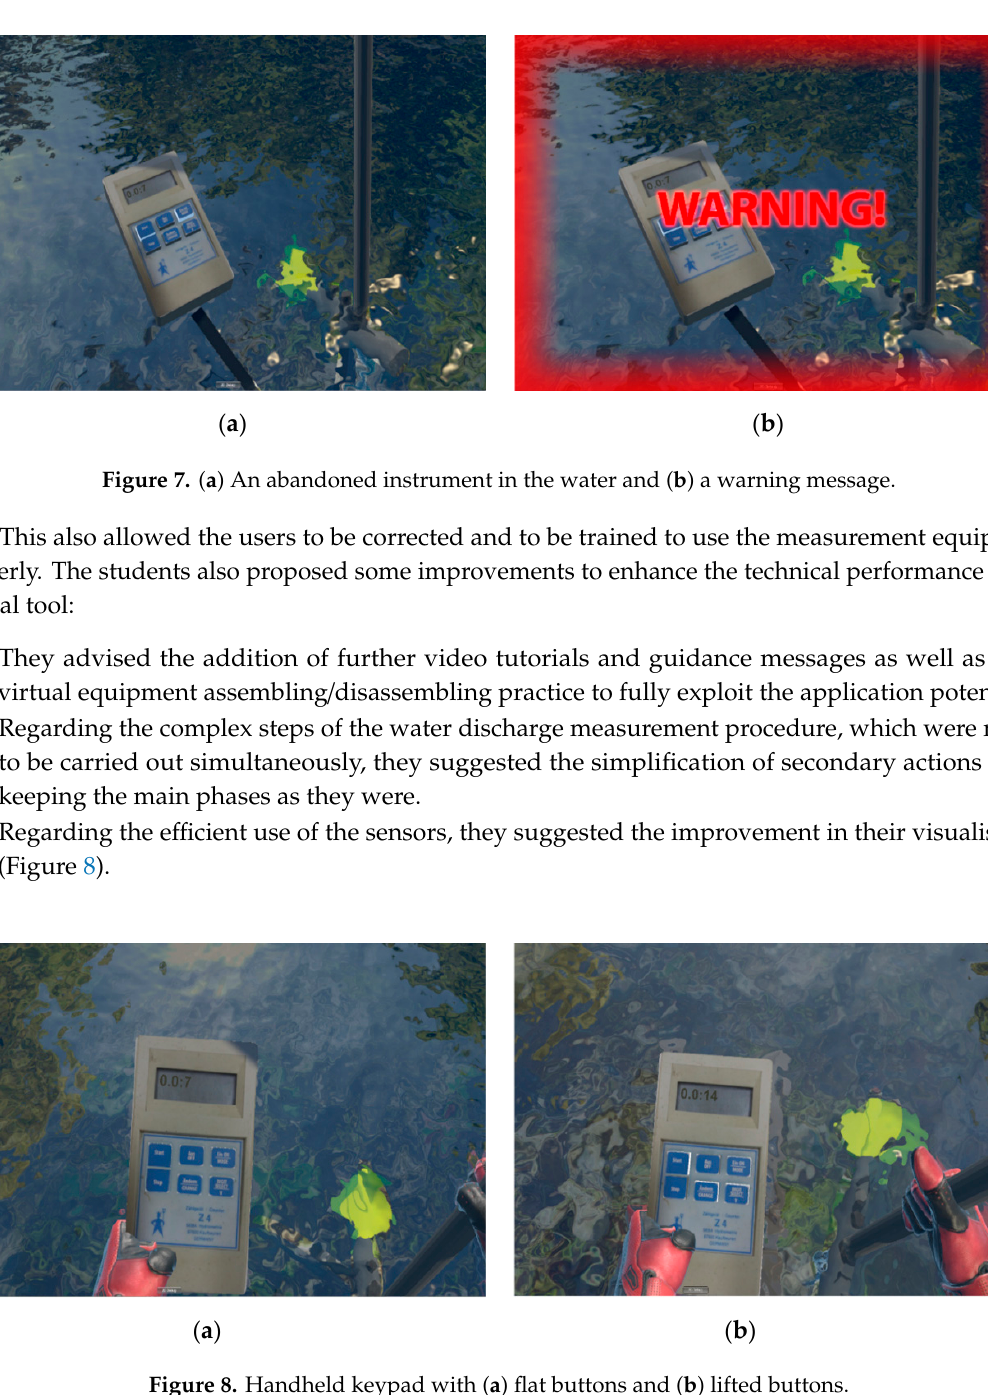
Figure 8. Handheld keypad with ( a ) flat buttons and ( b ) lifted buttons.